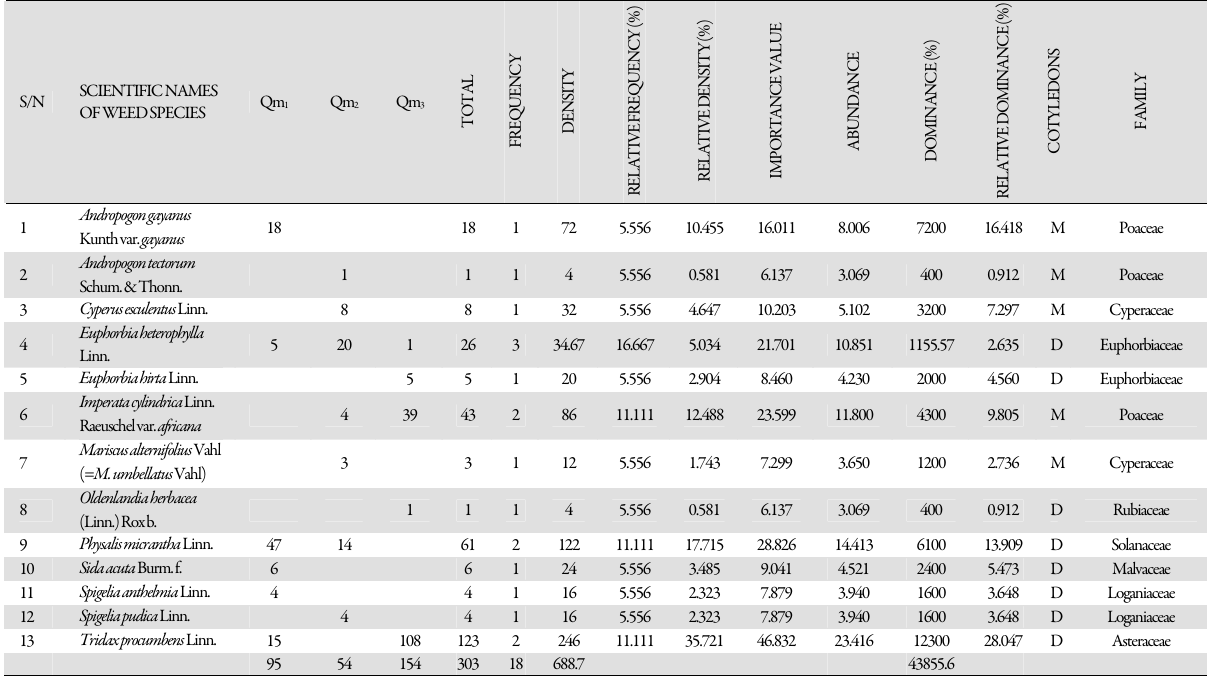
Tab. 1. Weed flora and species parameter for maize plot at 3WAP